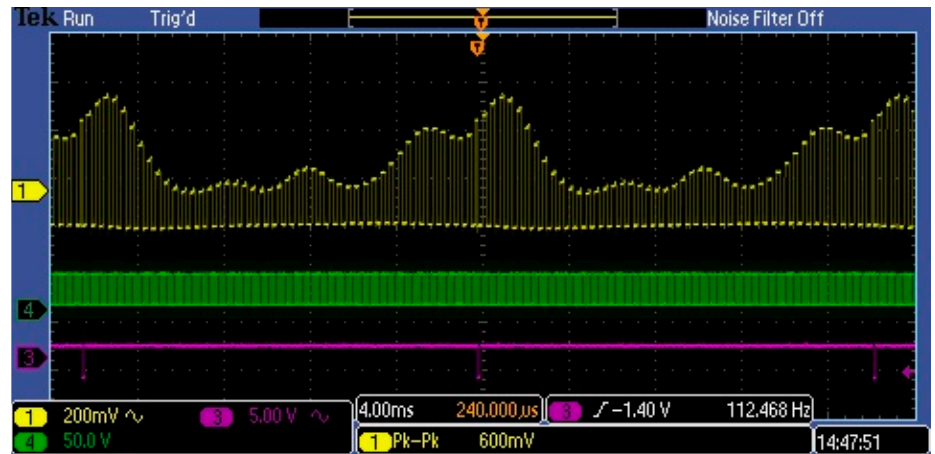
Figure 10. Captured variable ingredient in Video signal with four lighting LEDs.